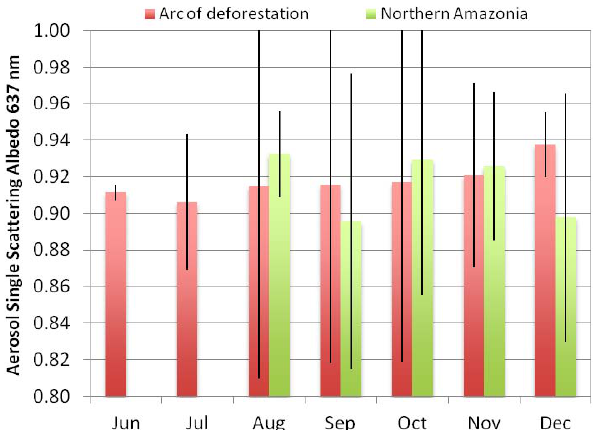
Fig. 8. Monthly averages of AERONET retrieved single scattering albedo between 1993 and 2011 at seven different locations in Ama- zonia: Ji Paran ´ a, Alta Floresta, Rio Branco (arc of deforestation), Balbina, Belterra, Santar´em, Manaus (northern Amazonia). All data is level 2, with exception to 9 Manaus data points in 2008, which are level 1.5. Particle SSA values observed in the AERONET wave- lengths were interpolated to 637nm. Error bars indicate standard